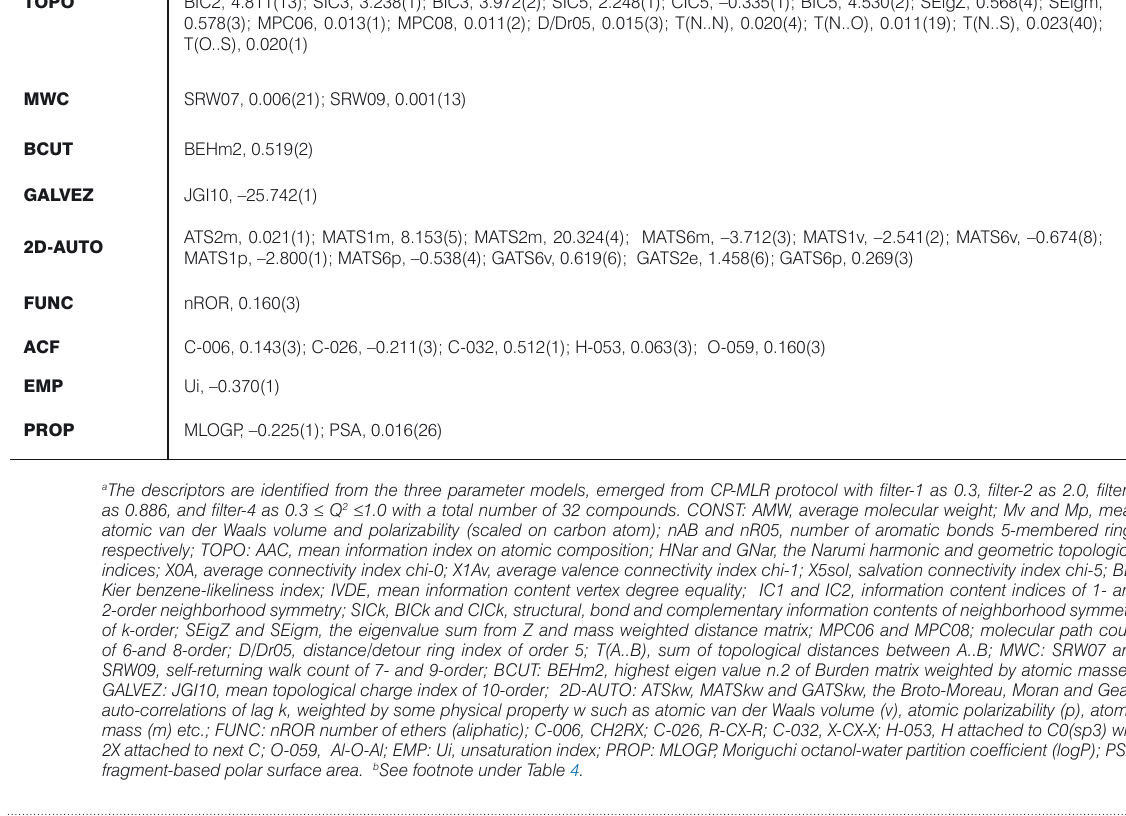
Table 5. Descriptor classes and identified descriptors in modeling the inhibition activities of human carbonic anhydrase, hCA II. Des. Class